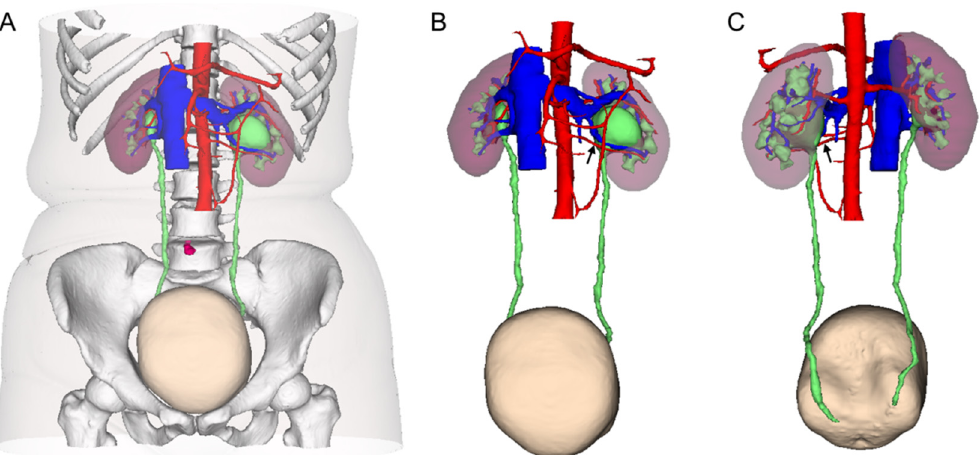
Figure 1. ( A ) Three-dimensional (3D) computerized tomography (CT) reconstruction model showing urinary system and its vascular system, skin, bones, belly button, etc. ( B ) Anterior view of 3D CT reconstruction model showing urinary system and its vascular system only. ( C ) Posterior review of 3D CT reconstruction model showing urinary system and its vascular system only. (Crossing renal artery in the lower pole of the kidney was indicated by black arrow.)